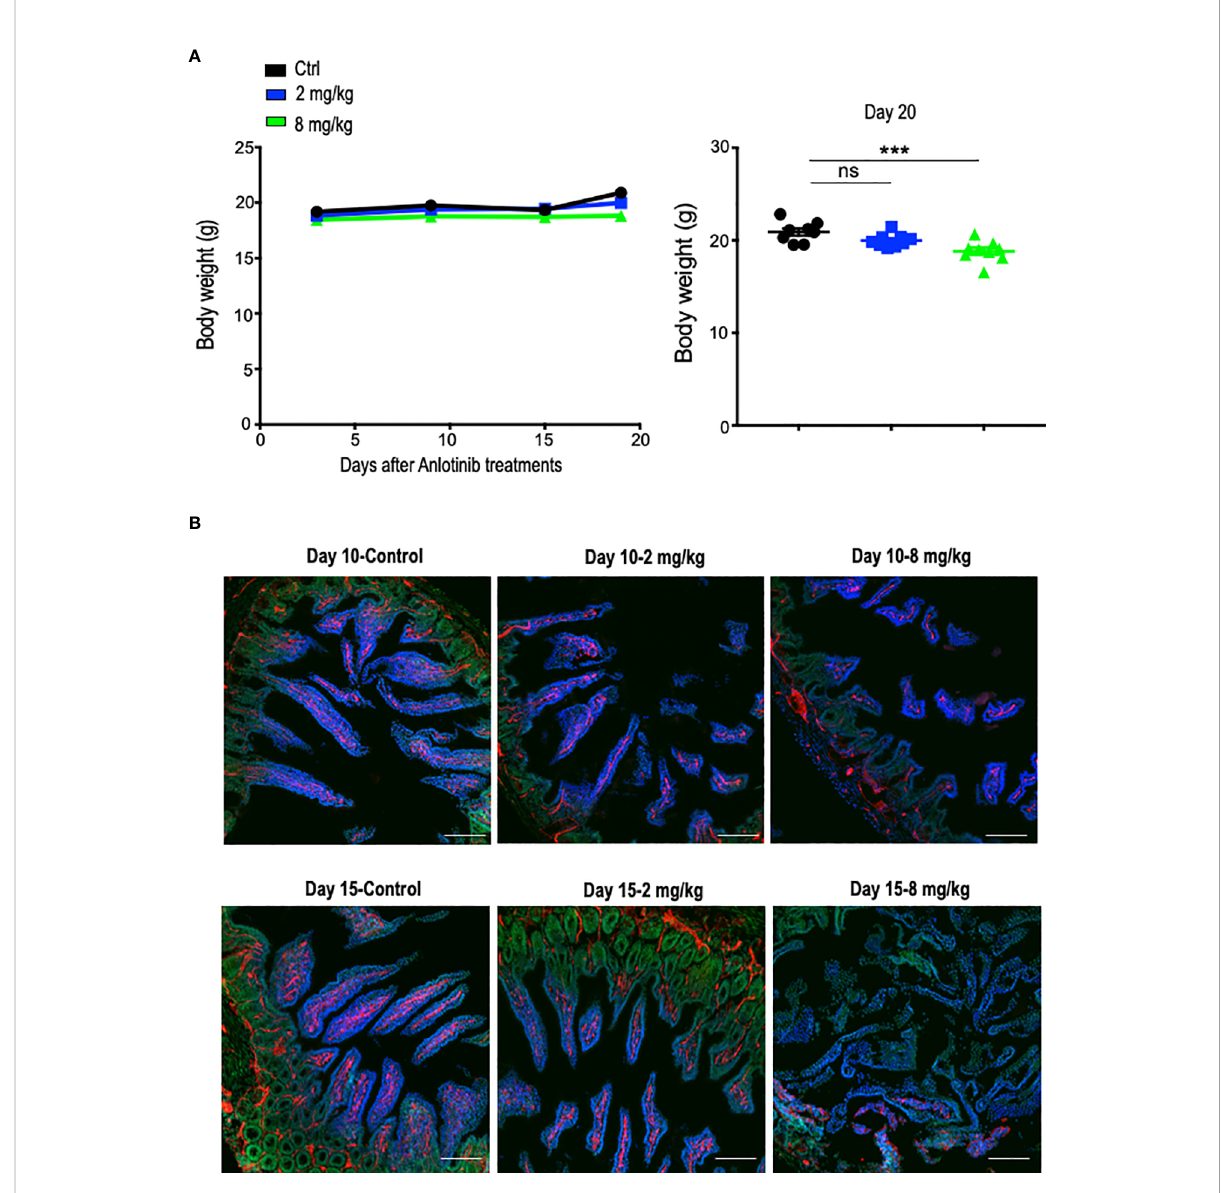
FIGURE 3 Long-term effective low-dose Anlotinib treatments exhibited fewer side effects compared to high-dose. EO771 tumor-bearing mice were prepared, and Anlotinib treatments were conducted as described in Figure 2. The duration of Anlotinib treatments was 20 days. Prior to colon tissue collection, mice were intravenously injected with 200 µg/mouse Hoechst 33342 (Ho33342). (A) The body weight of mice was monitored every 5 days post-Anlotinib treatments. The signi fi cance was determined by one-way ANOVA ( n = 8 – 9 mice per group). The data are presented as means±SEM. ns, no signi fi cant difference; *** p < 0.001. (B) Representative images of colon tissues from vehicle control and mice treated with low- or high-dose Anlotinib. Each group had eight to nine mice. Ho33342 perfusion (blue) indicating blood vessel function and CD31 (red) staining blood vessels. Scale bar=100